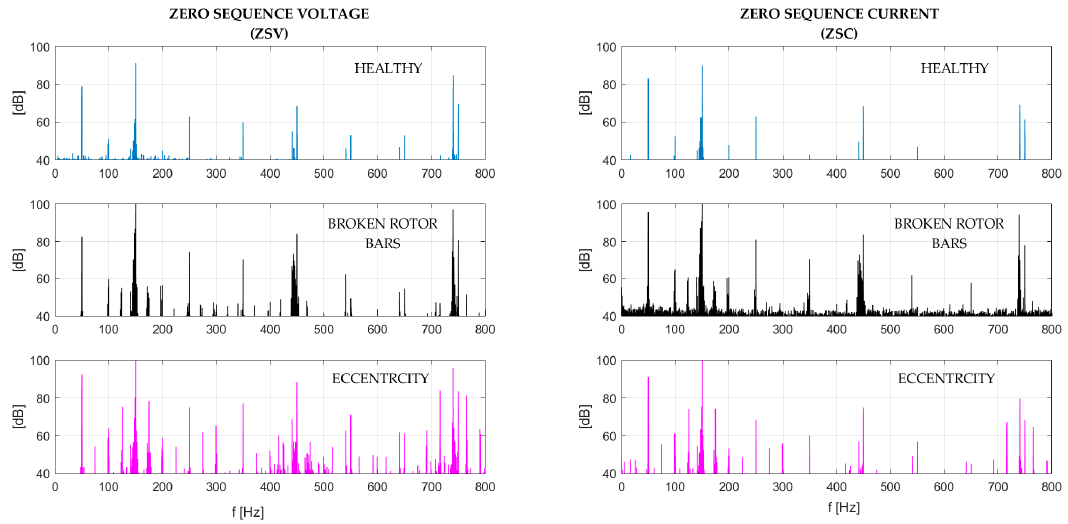
Figure 3. Exemplary comparison of ZSV (winding connected in star mode) and ZSC (winding connected in star mode with neutral wire) spectra for a healthy motor and a motor with a one broken rotor bar and eccentricity.